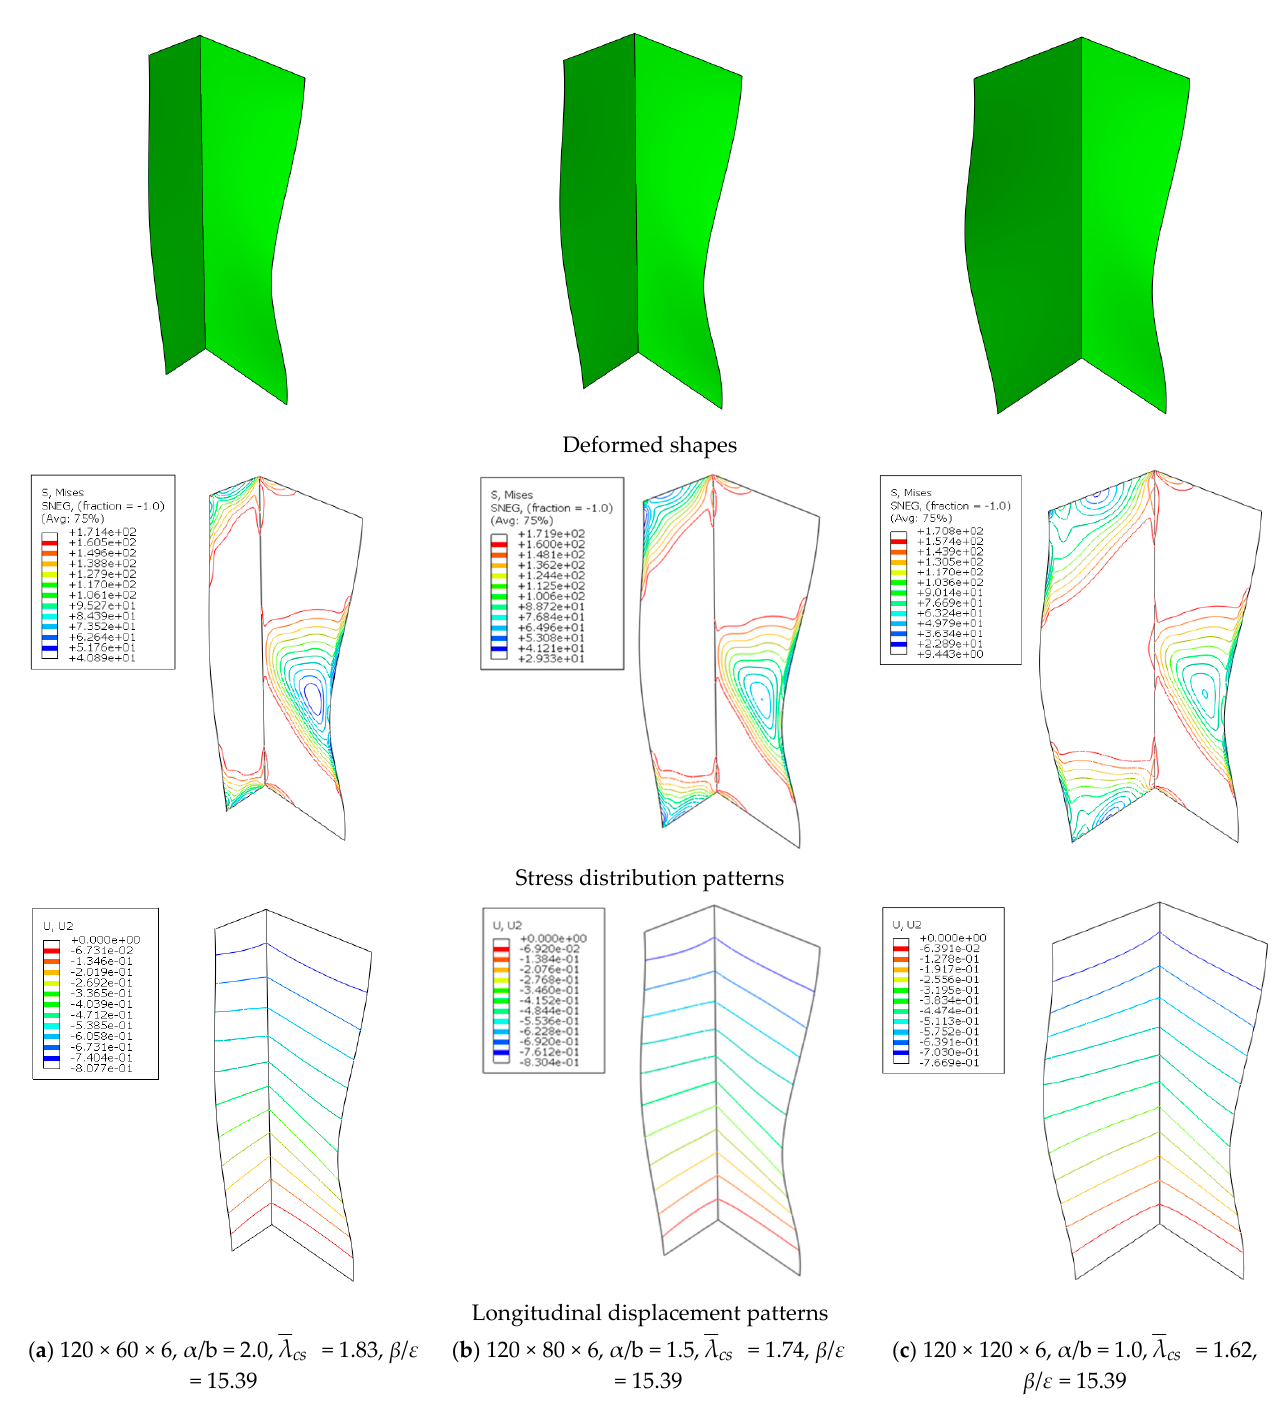
Figure 5. Deformed shapes ( top ), stress distribution patterns ( middle ) and longitudinal displacement patterns ( bottom ) at failure load for typical 6063-T5 cross-sections.